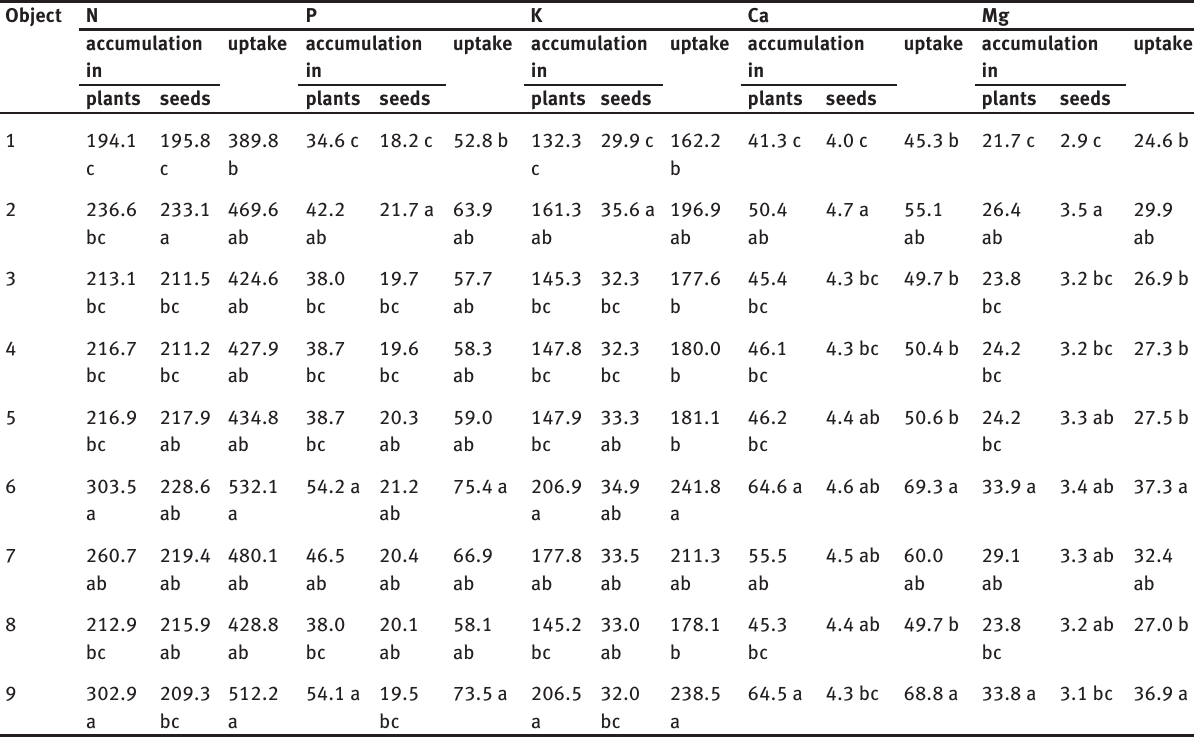
Table 5: The influence of vaccination treatment on accumulation of mineral composition in plants and seeds of white lupine and their uptake (kg∙ha -1